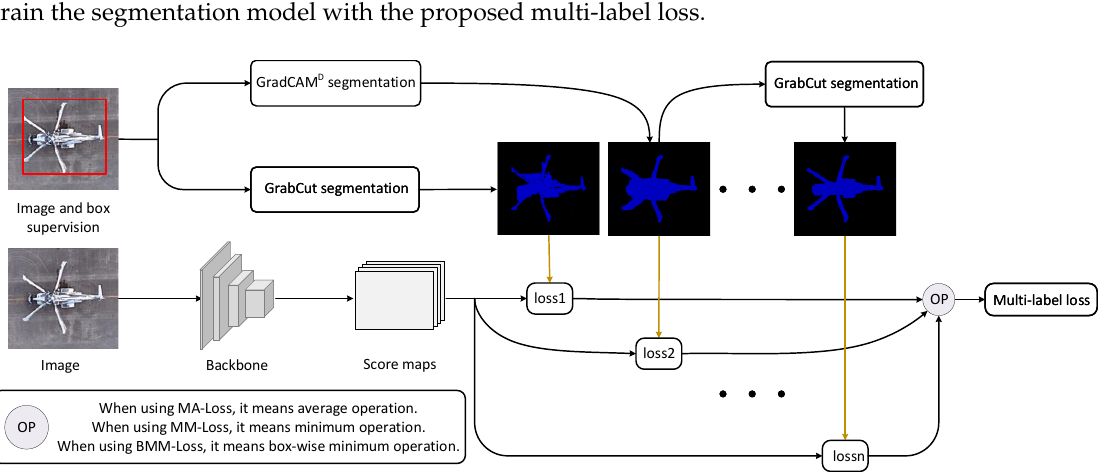
Figure 3. Overview of JMLNet. We generate multiple proposals as multi-label supervision and use multi-label loss to train the segmentation